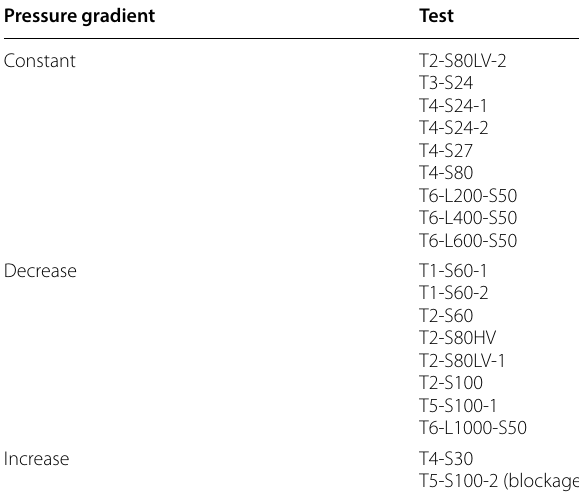
Table 4 Classification of pressure gradient change over the pipe